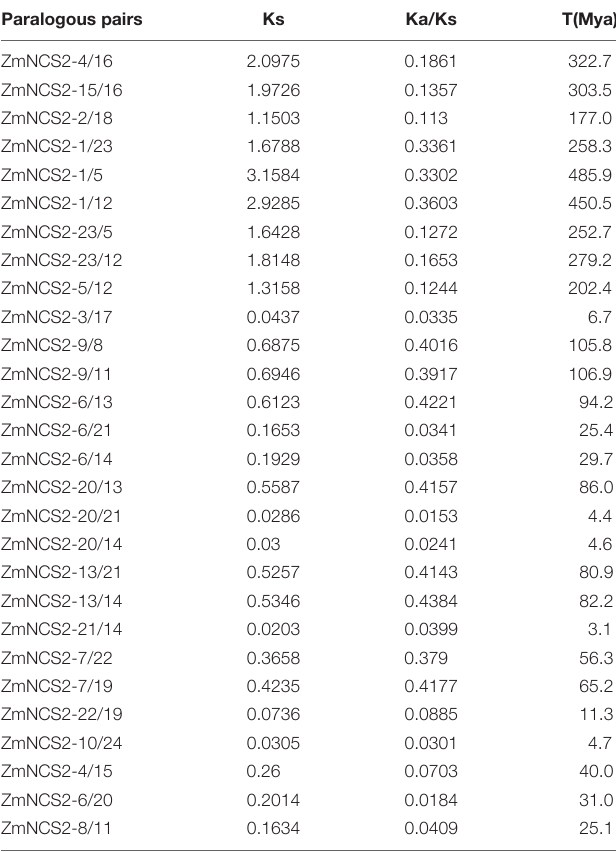
TABLE 4 | Ka/Ks values and the estimated divergence times for the duplicated NCS2 paralogs in Zea mays. Paralogous pairs Ks